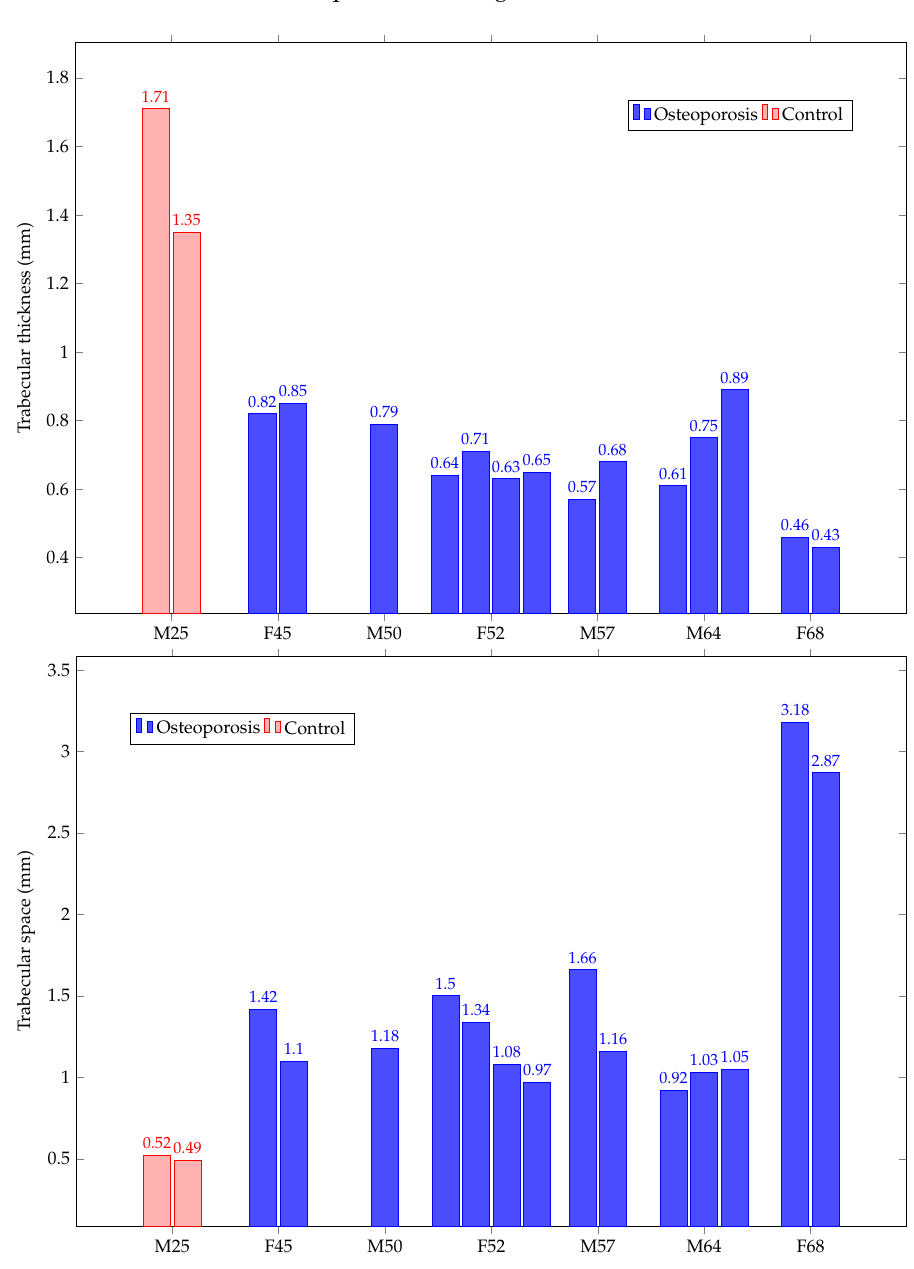
Figure 7. Summary of results for Tb.Th ( top ) and Tb.Sp ( bottom